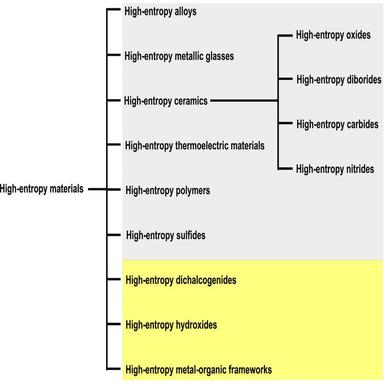
Reported (gray area) and potential (yellow area) high-entropy materials.